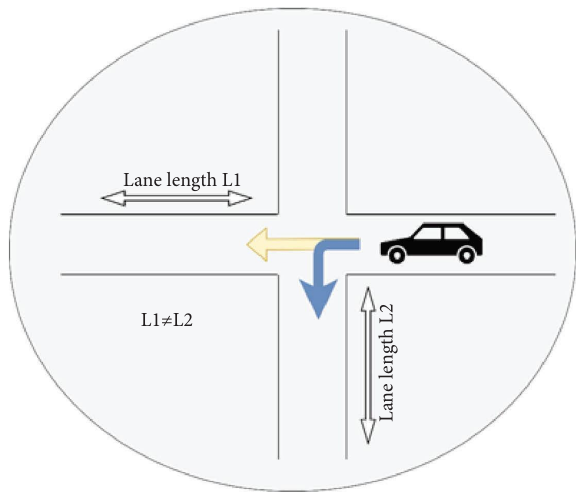
Figure 3: Problem in T